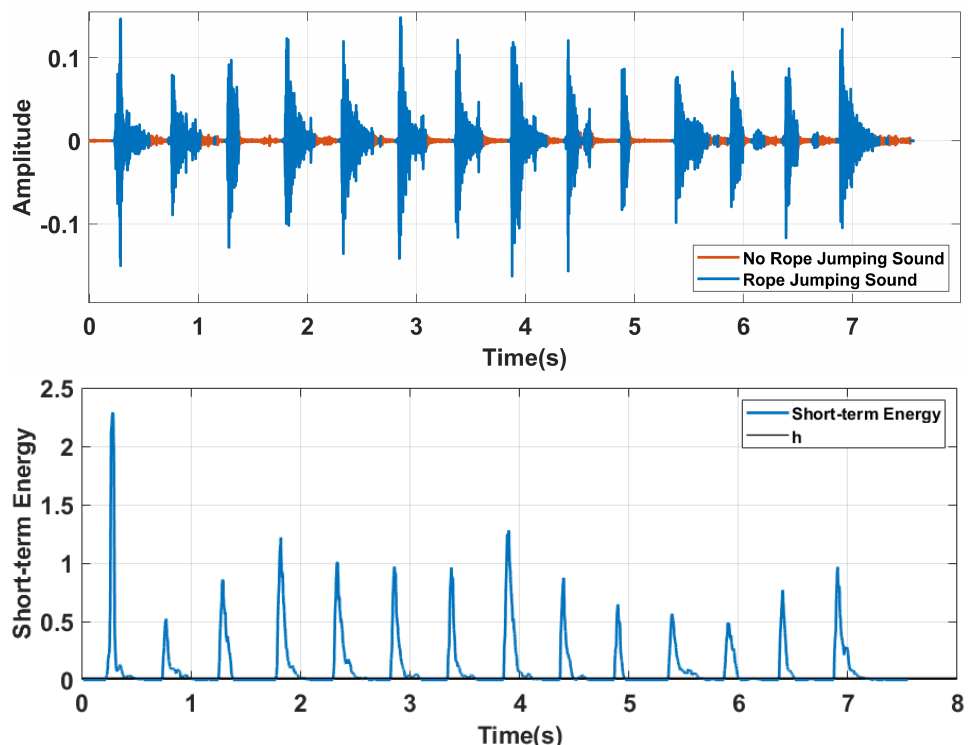
Figure 3. An example of the rope − jumping sound